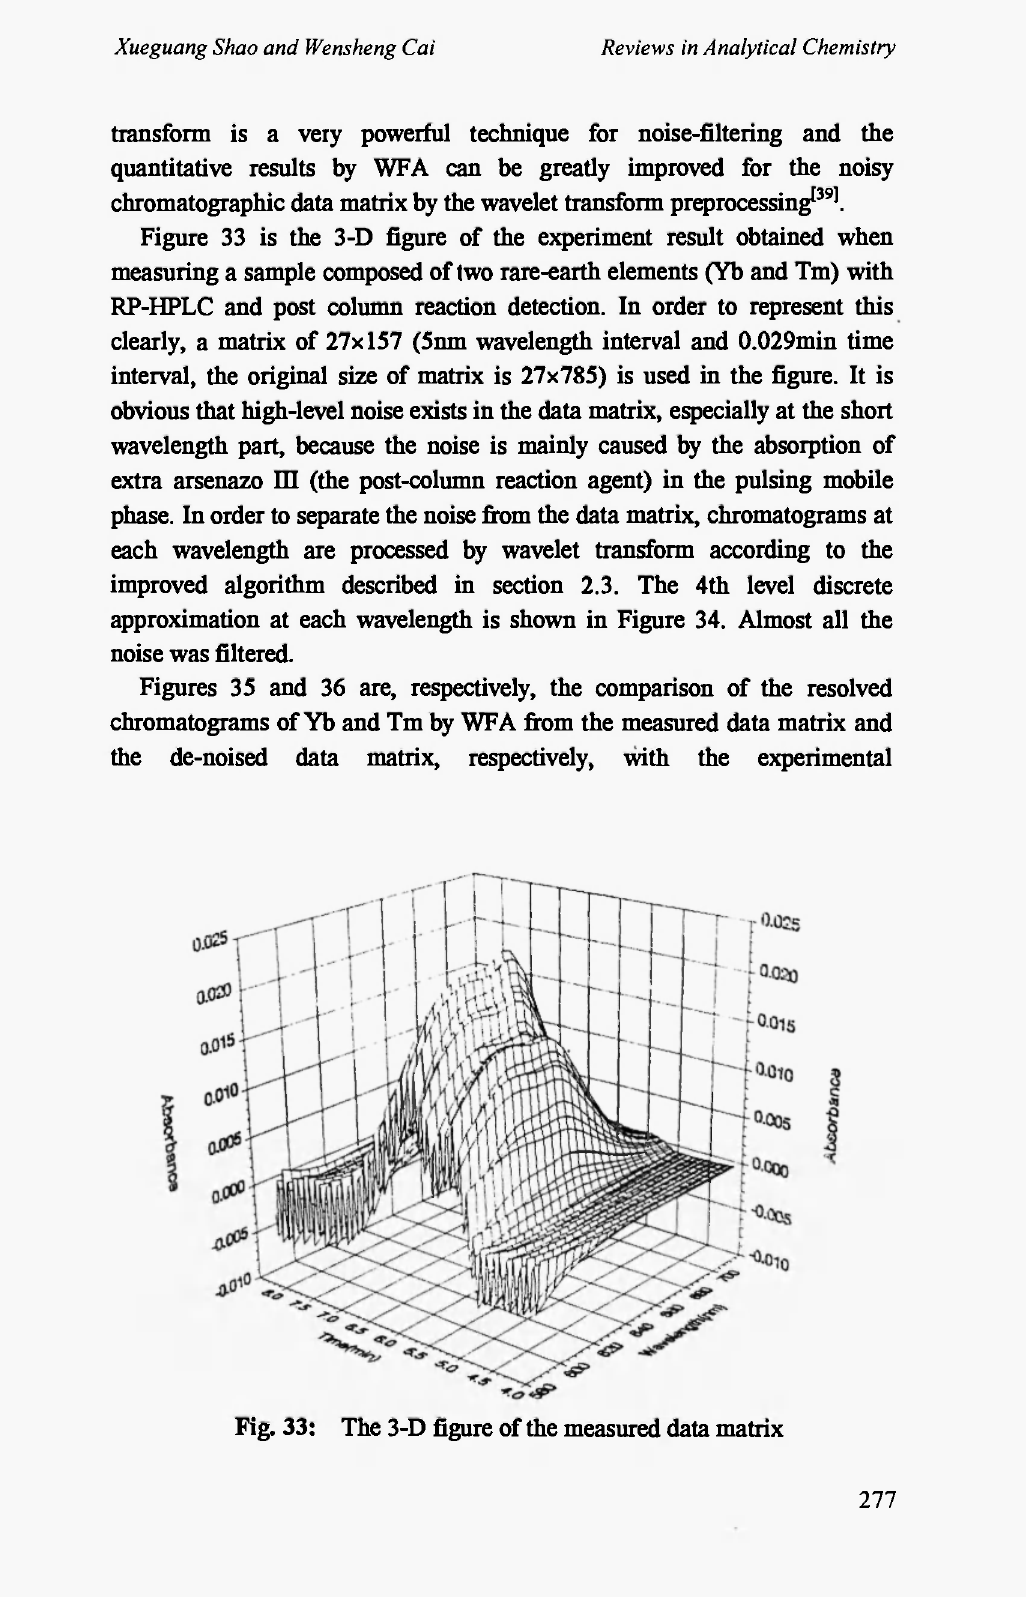
Fig. 33: The 3-D figure of the measured data matrix